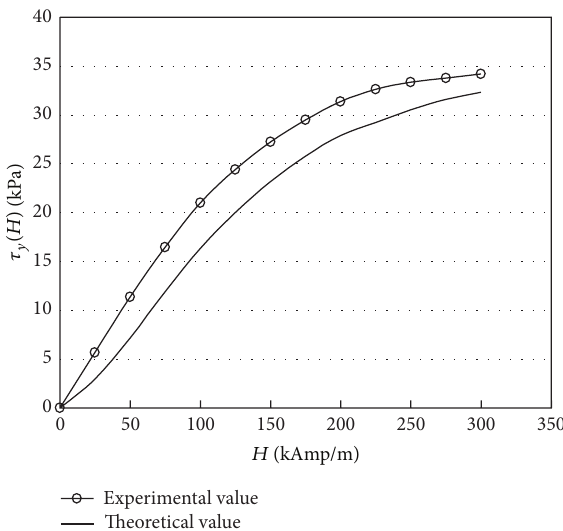
Figure 6: The yield stress versus applied magnetic field strength.